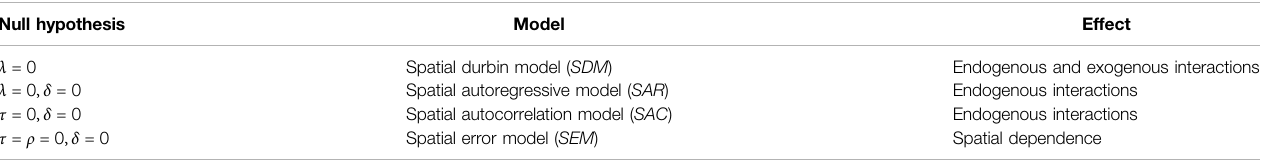
TABLE 1 | Adaptability test of spatial econometric model. Null